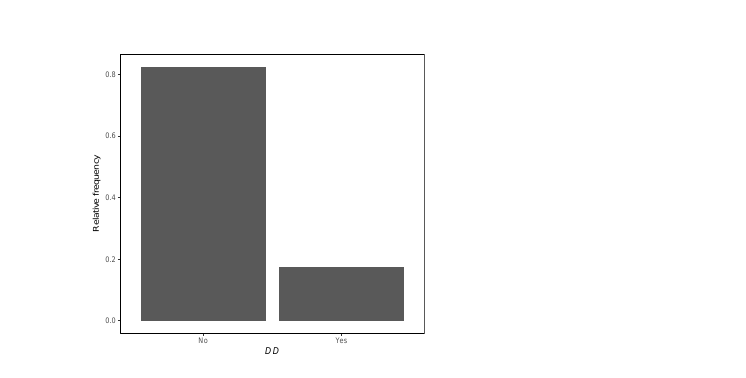
Figure A1. Illustration of the relative frequencies of the claim severity S along risk factors in the training sample. Table A1. Regression results of the GAM (Equation (1)) and GLM (Equation (3)) calibrated on the training